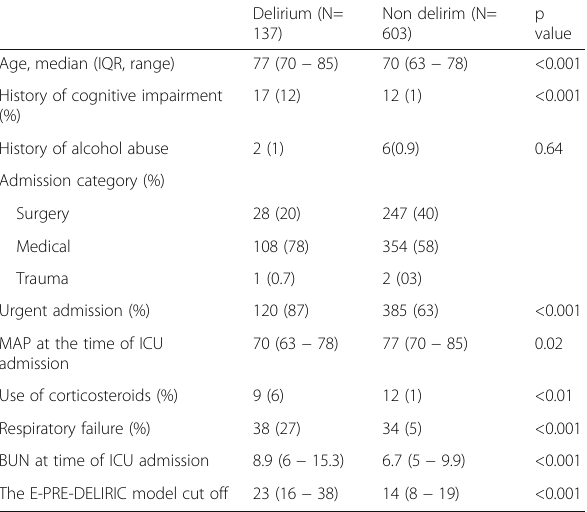
Table 1 (abstract 000073). See text for